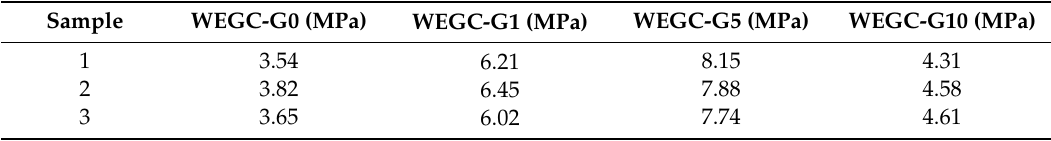
Table 1. Pull-o ff test results of WECG on Q235